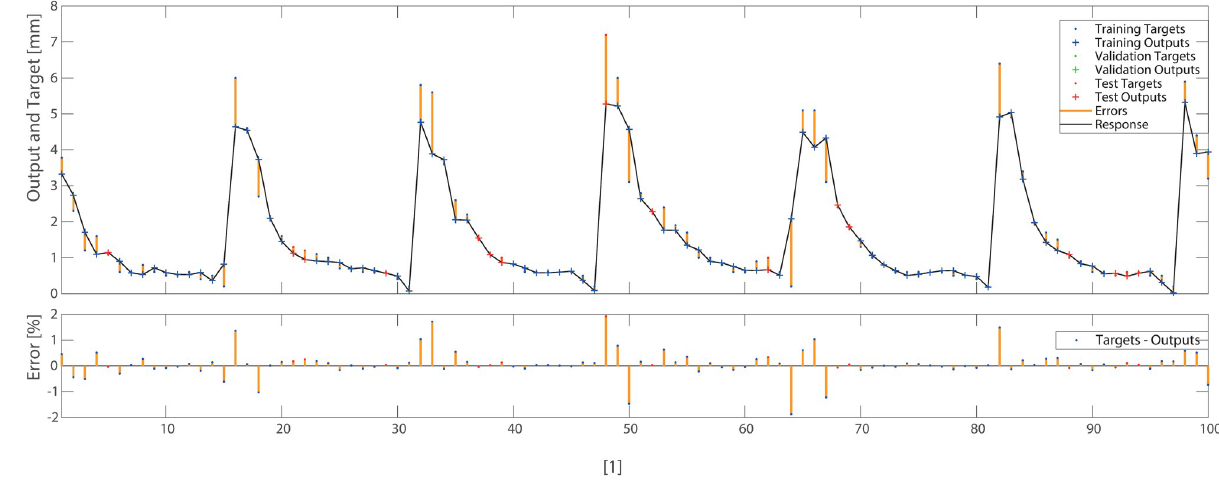
Fig 3. Histogram of ANN errors with 20 bins for 2(1)-20–1 networked trained with BR, evaluated for pine data.